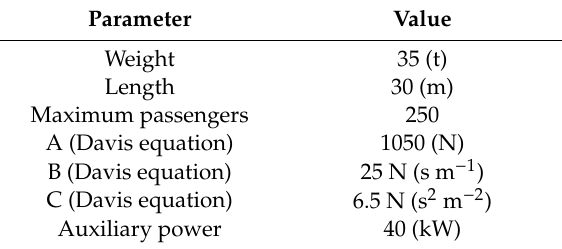
Table 3. Vehicle features.